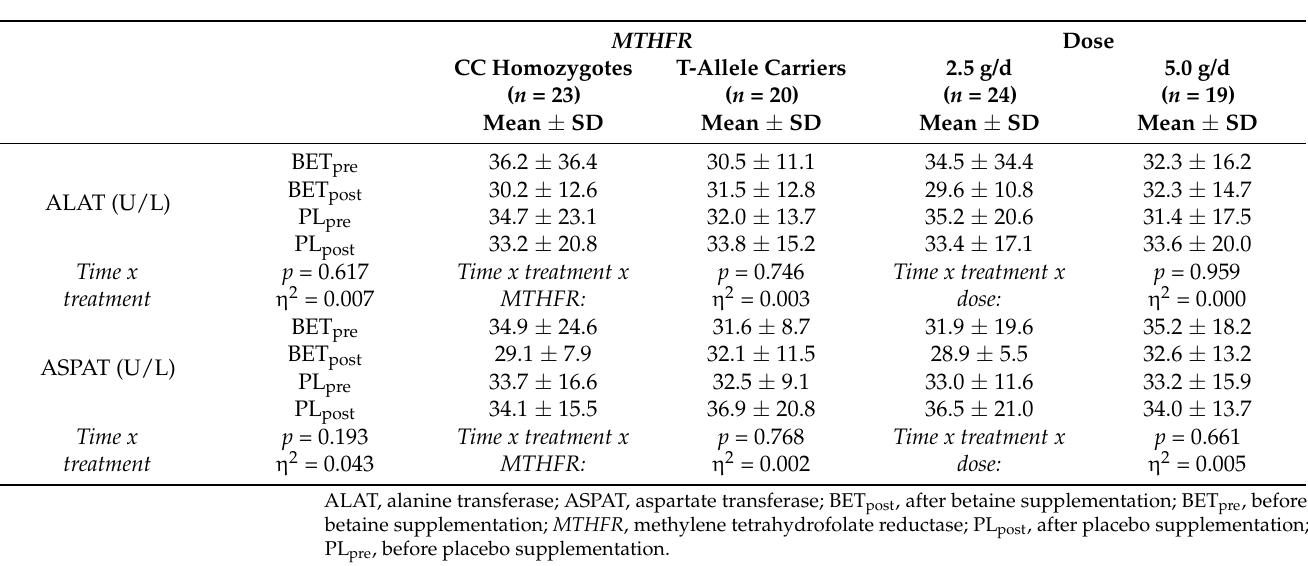
Table 6. The effect of betaine supplementation on liver enzymes and its relation to MTHFR genotype and BET dose.